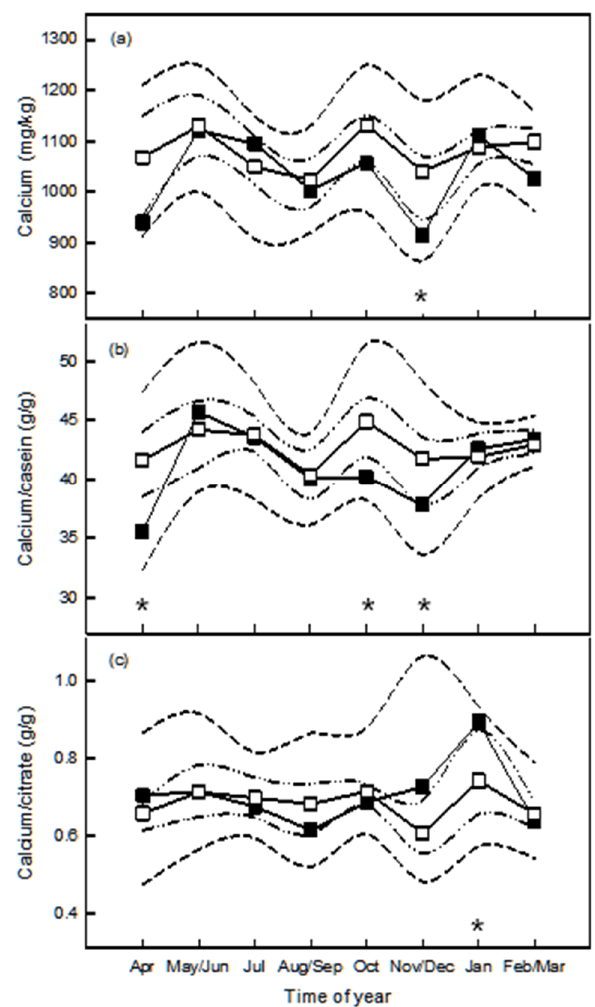
Figure 1. The average concentration of ( a ) calcium in milk, ( b ) the ratio of calcium to casein and ( c ) ratio of calcium to citrate in milk from herds that either received ( (cid:3) ) or did not receive ( (cid:4) ) mineral supplements high in calcium by the time of year the sample was collected. An asterisk indicates a significant difference exists between herds receiving and not receiving a supplement of calcium at that time of year. Dashed lines indicate the minimum and maximum values observed at each period; dash-dot-dot lines indicate the lower and upper quartiles; all have been smoothed using a cubic spline function.